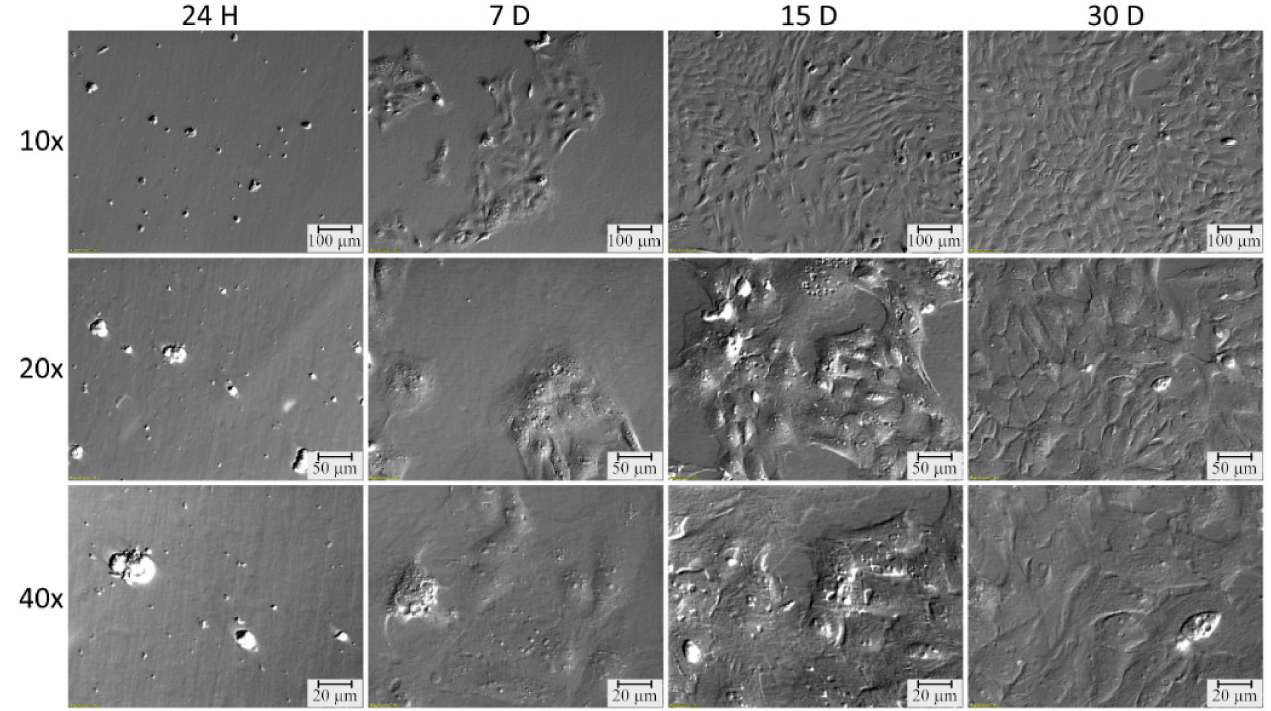
Figure 11. Pictures of porcine oviduct epithelial cells cultures used for the experiment, presenting changes in their morphology, following 24 h, and 7, 15 and 30 days of in vitro culture (magnification × 10, 20 and 40, as